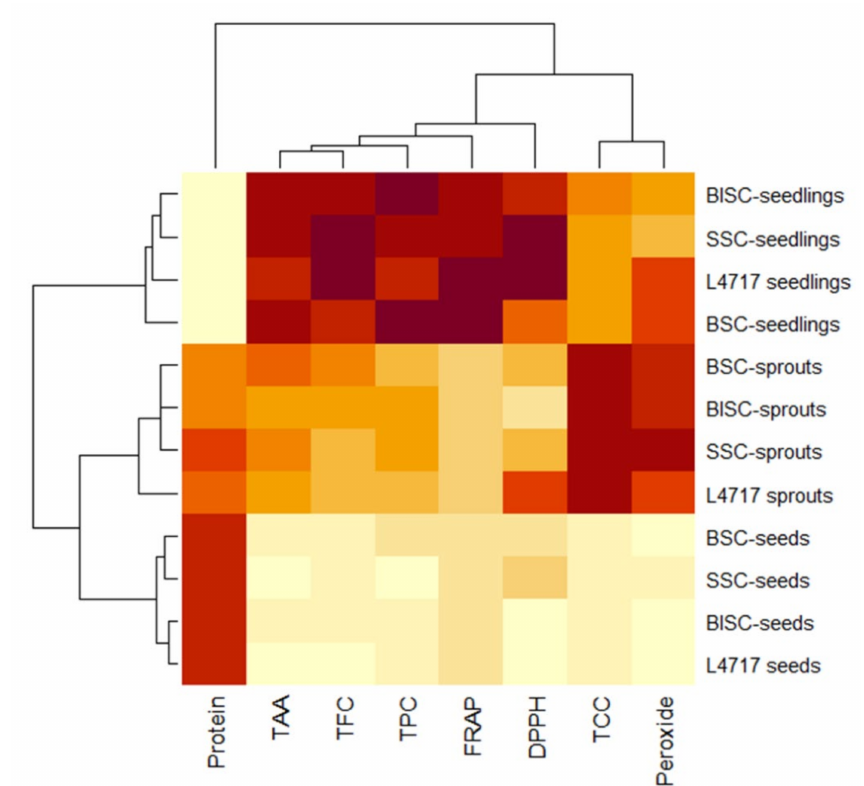
Figure 6. Hierarchical cluster analysis and heatmap visualization of physiochemical, nutritional, and nutraceutical data of 12 lentil samples. Diverse colors in each row indicate differences in the values estimated for each parameter among the 11 samples. BSC (brown seed coat), BlSC (black seed coat), and SSC (spotted seed coat) from L4717-NM genotype.